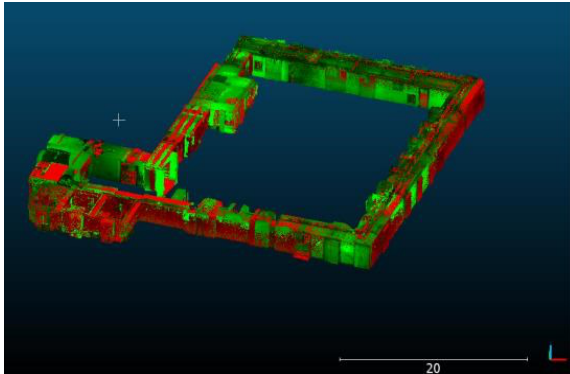
Figure 4: Reference and MMS point clouds aligned The results of the comparison are similar to the previous dataset.